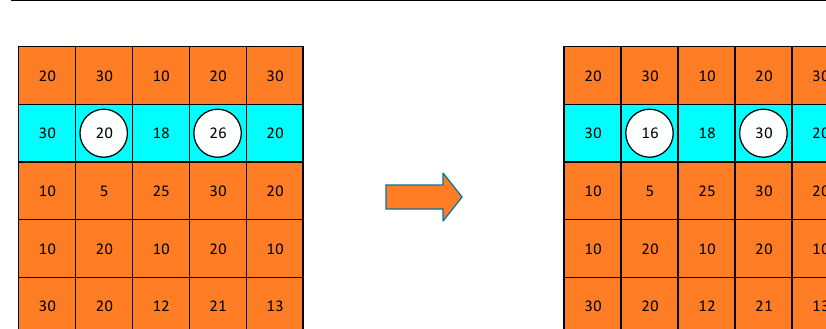
Figure 4. Evolution process of the lot split population.